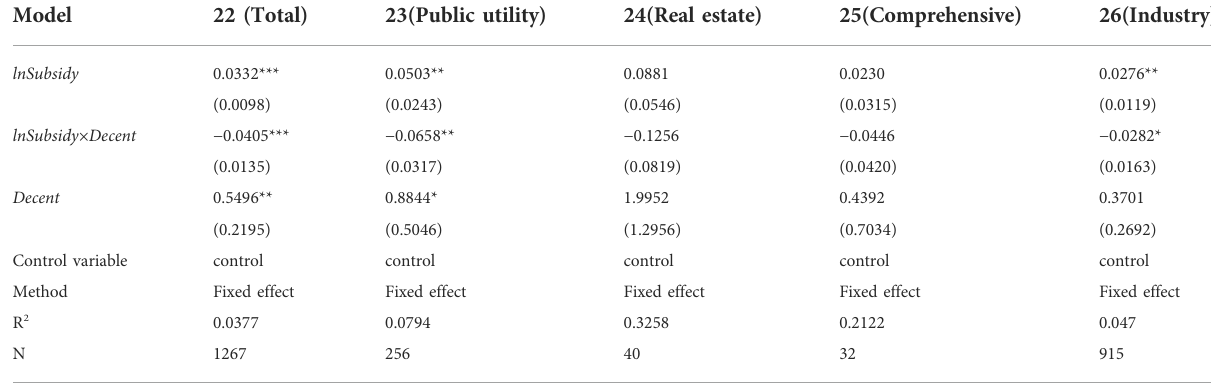
TABLE 9 Results of the regulation